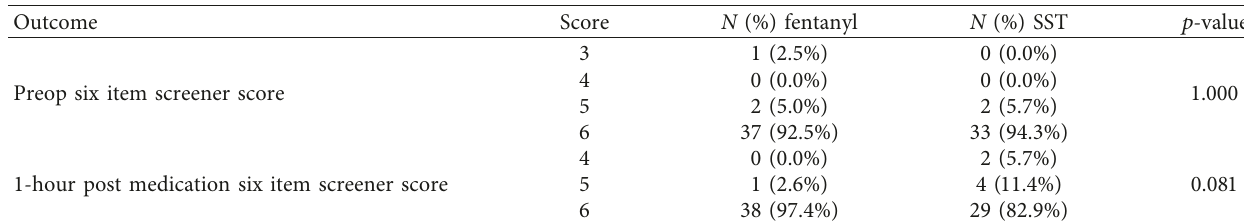
Table 4: Six item screener